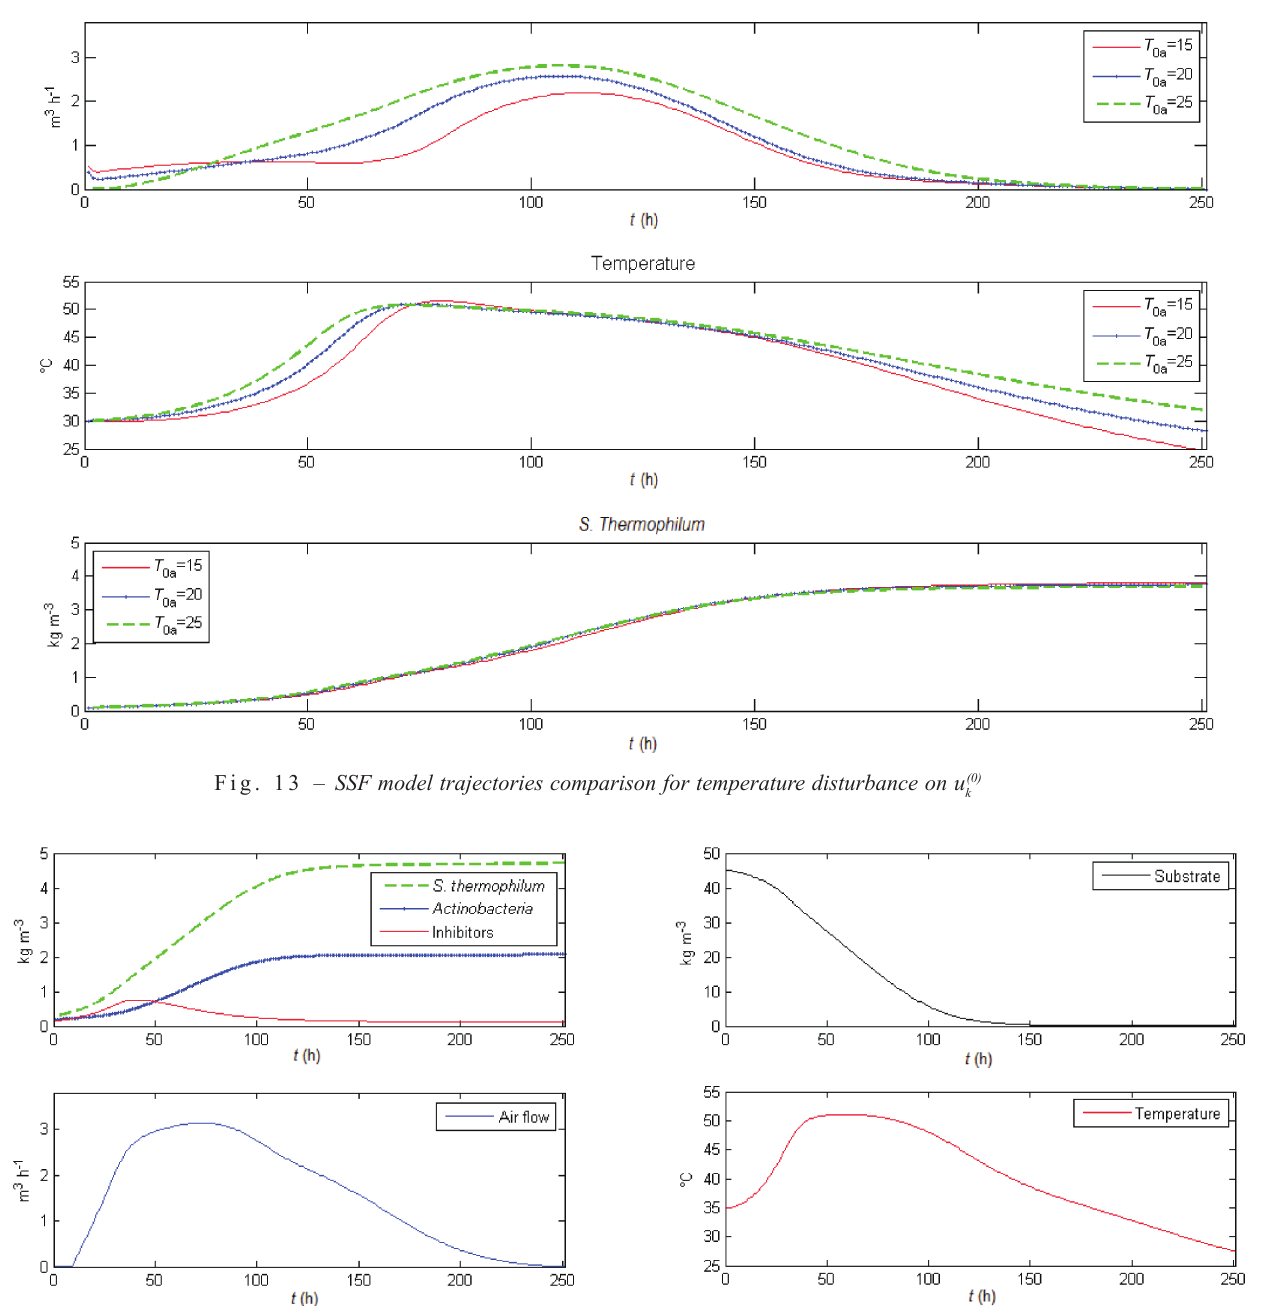
Fig. 14 – SSF model response with initial conditions